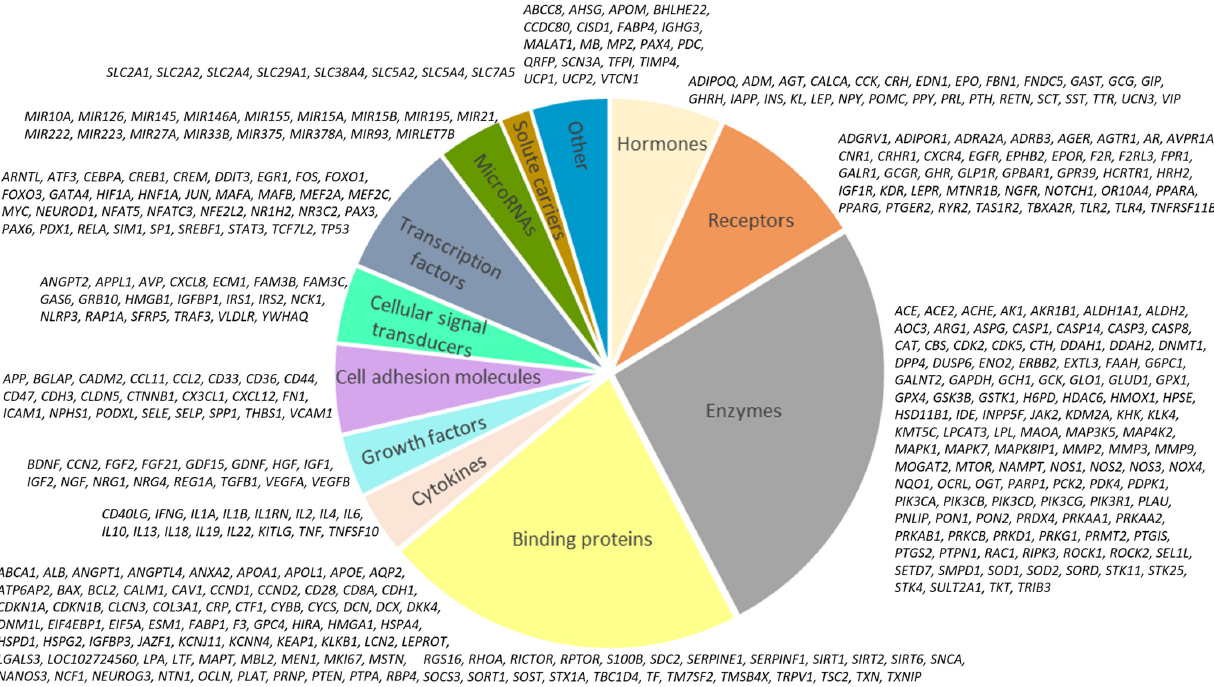
Figure 2. Molecules in the hyperglycemia-associated network.